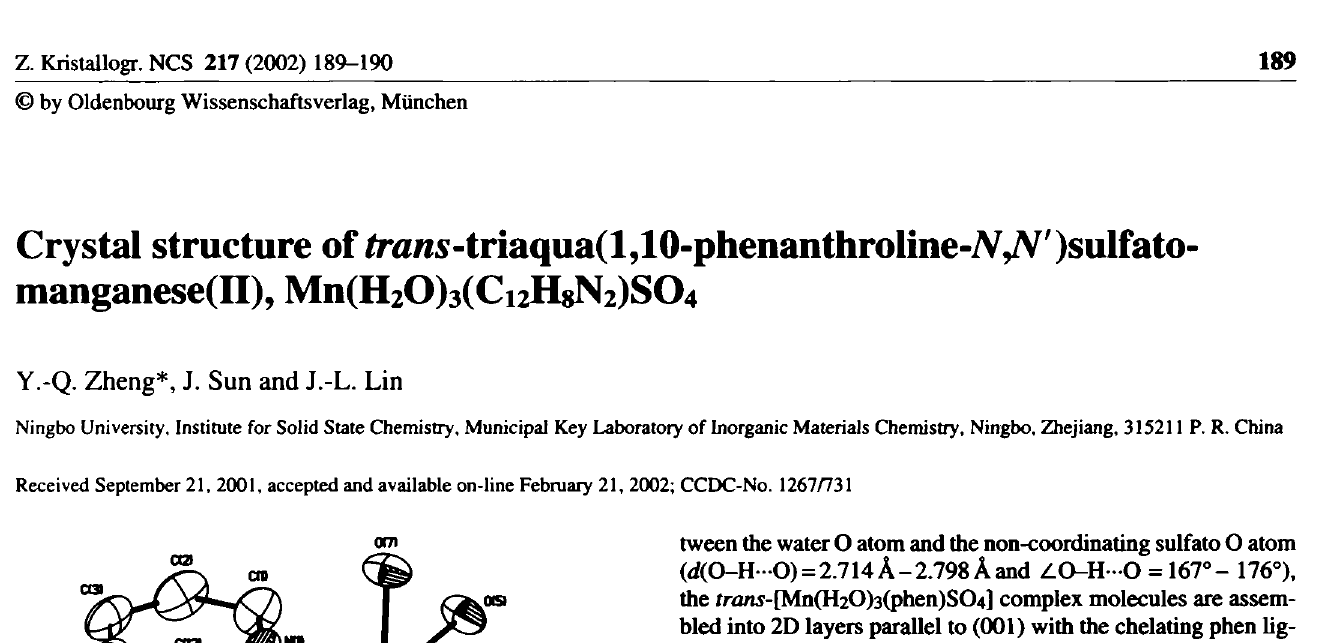
Table 1. Data collection and handling